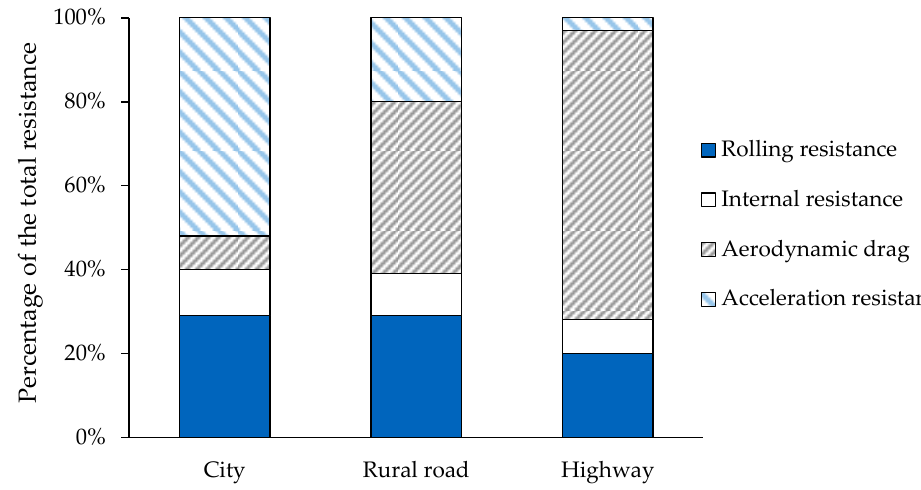
Figure 1. Percentage distribution of the vehicle resistance in different driving scenarios [10] (p. 36).